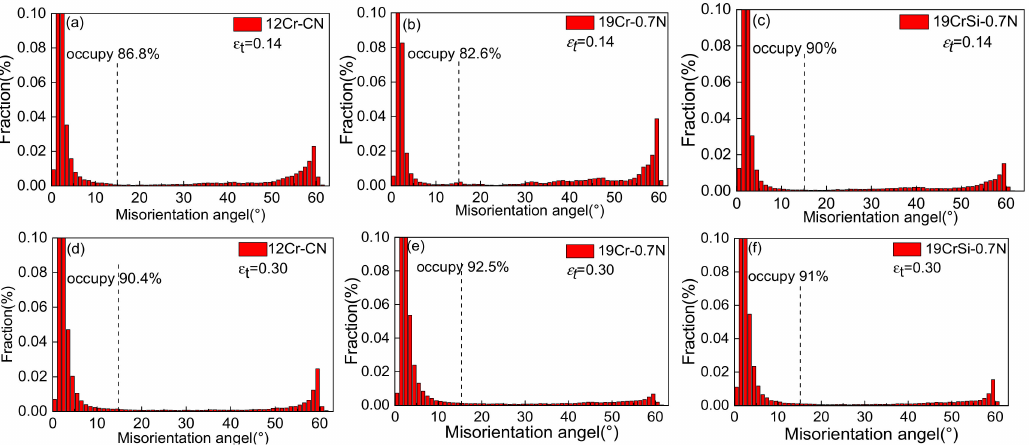
Figure 8. Distribution of orientation difference of TWIP tensile specimen at ε t = 0.14 ( a ) and ε t = 0.30 ( d ) of 12Cr–CN, at ε t = 0.14 ( b ) and ε t = 0.30 ( e ) of 19Cr–0.7N, at ε t = 0.14 ( c ) and ε t = 0.30 ( f ) of 19CrSi–0.7N.